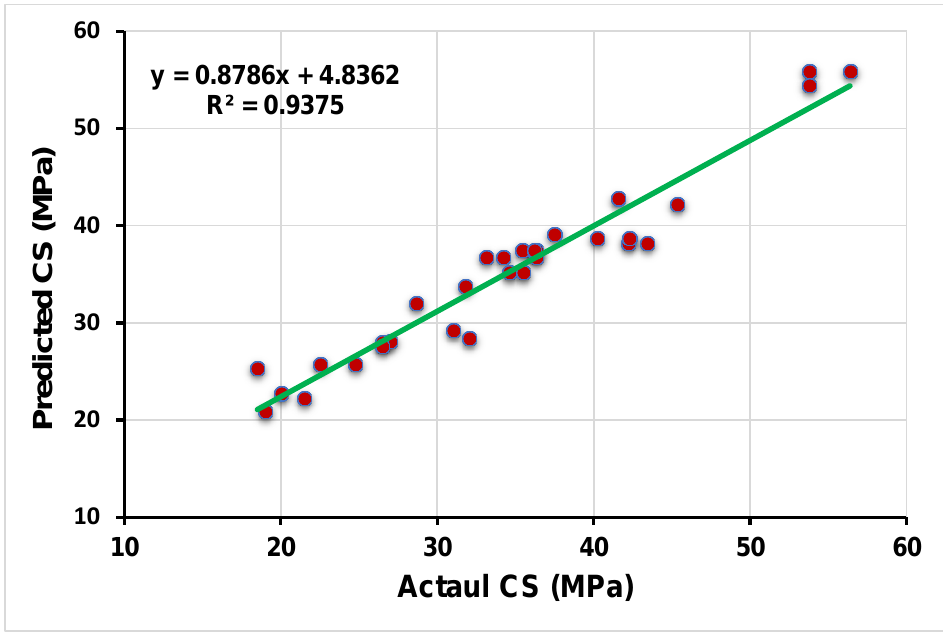
Figure 6. Relationship between the targeted and predicted results obtained from AdaBoost approach.